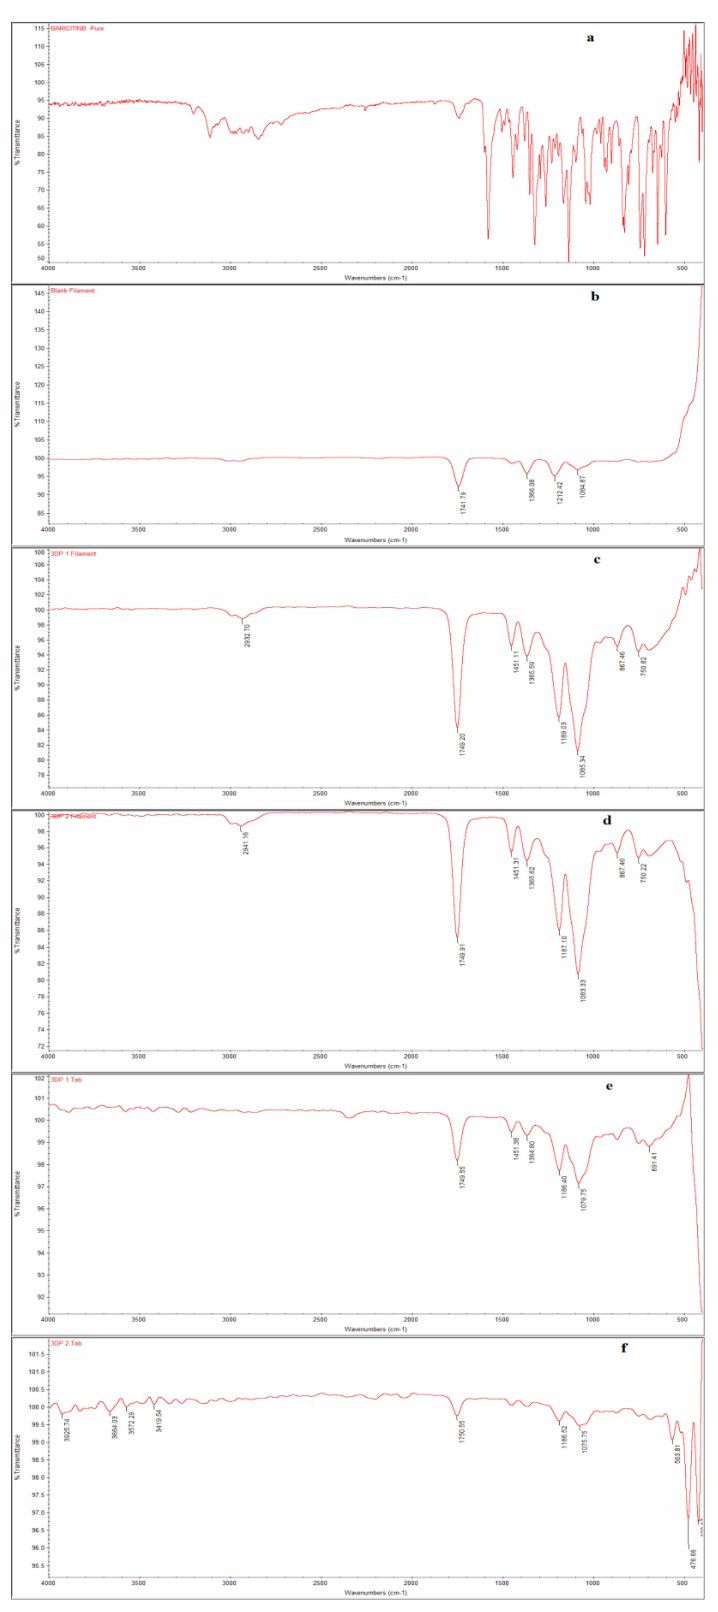
Figure 6. FTIR spectrums of ( a ) BAB, ( b ) PLA, ( c ) 3DP1, ( d ) 3DP2 filaments, and ( e , f ) for 3D pills fused with